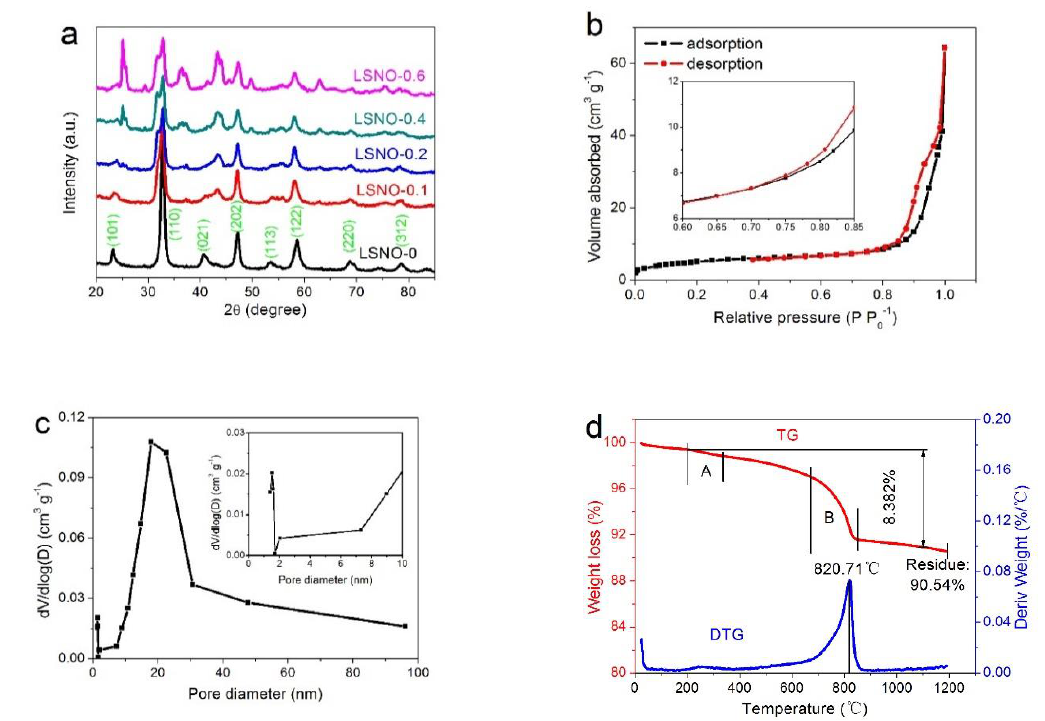
Figure 1. ( a ) XRD patterns of LSNO-x samples; ( b ) N 2 adsorption-desorption isotherms and ( c ) pore size distributions of the LSNO-0.4 sample, and ( d ) TG and DTG curves of the LSNO-0.4 sam-